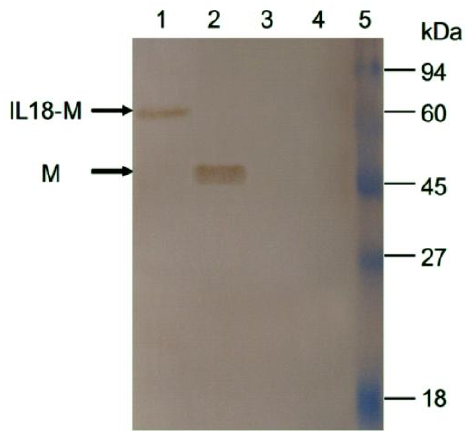
Figure 3. Western blot analysis of lysates of recombinant eukaryon expression plasmids transfected cells, pEGFP-IL18-M (lane 1), pEGFP-M (lane 2), pEGFP-N1 (lane 3), and negative control (lane 4). MARC-145 cells lysates without transfection were used as the control. Protein marker is shown on the right